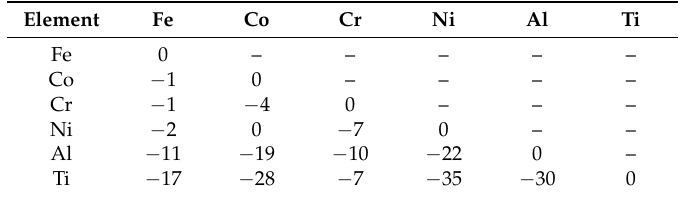
Table 2. The mixing enthalpy of atomic pairs between these six elements (kJ/mol) [16]. Element